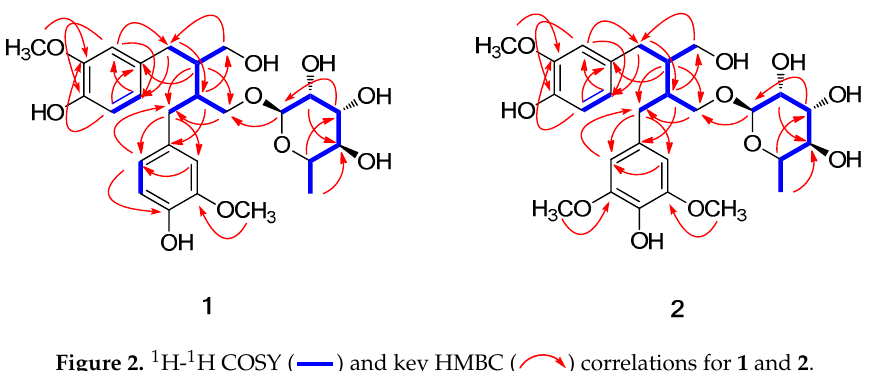
Figure 2. 1 H- 1 H COSY ( ) and key HMBC ( ) correlations for 1 and 2 . Table 1. 1 H and 13 C NMR data of 1 and 2 in CD 3 OD ( δ in ppm, 800 MHz for 1 H and 200 MHz for 13 C) a .